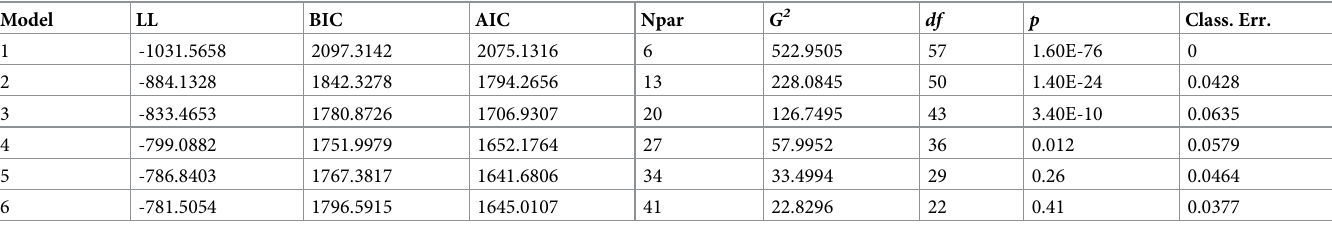
Table 2. Fit indices for the latent class models of pregnant women’s perceptions of threat.